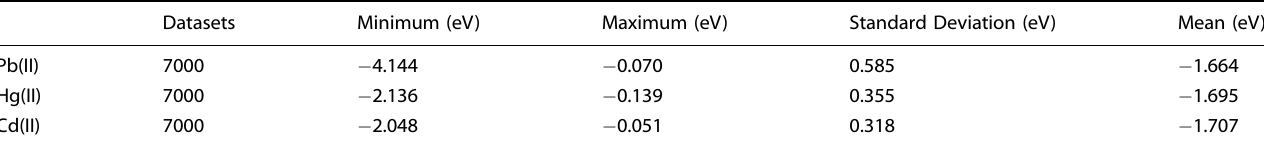
Table 2. Adsorption ability comparison of g-C 3 N 4 material towards three HMIs.